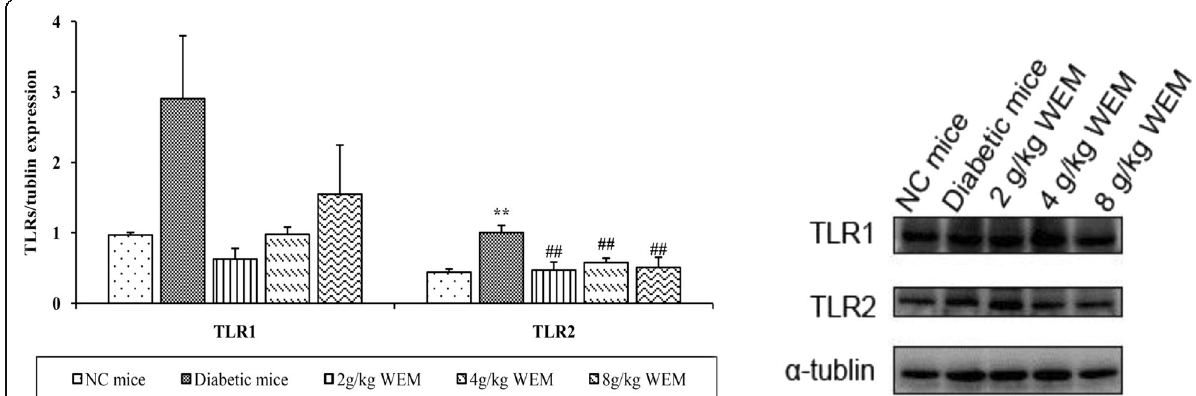
Fig. 7 Effect of WEM treatment on protein expression TLR1 and TLR2. A significant decrease in TLR2 expression was observed with WEM. Normalized results are expressed as means ± SEM ( n = 3). * P < 0.05, **P < 0.01, NC mice vs. Diabetic mice; # P < 0.05, ## P < 0.01, WEM vs. Diabetic mice